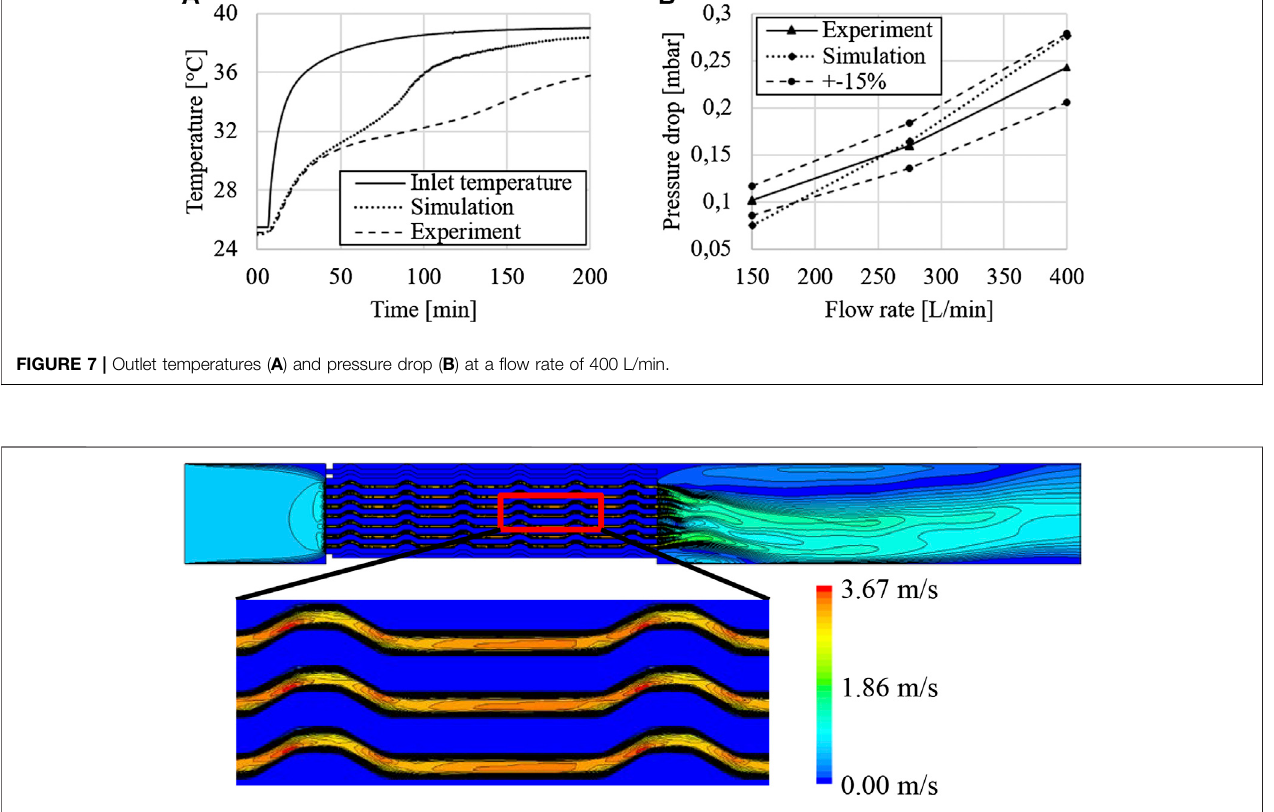
FIGURE 8 | Simulated velocity plots of the test rig duct: similar fl ow patterns can be observed in the channels between the plates.